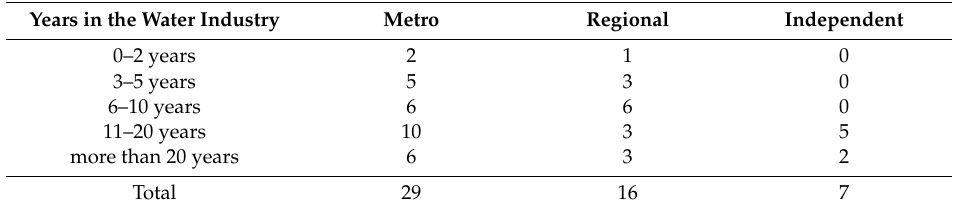
Table 1. Years of experience in the water industry by water business service organisation type. Years in the Water Industry